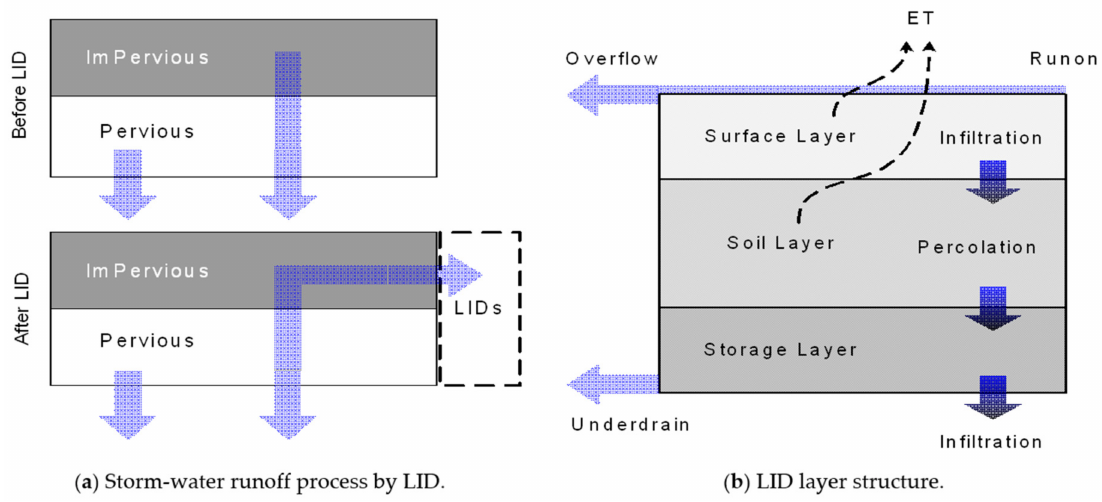
Figure 2. Conceptual diagram of the storm-water runoff process by LID facility and LID layer structure in SWMM-LID model